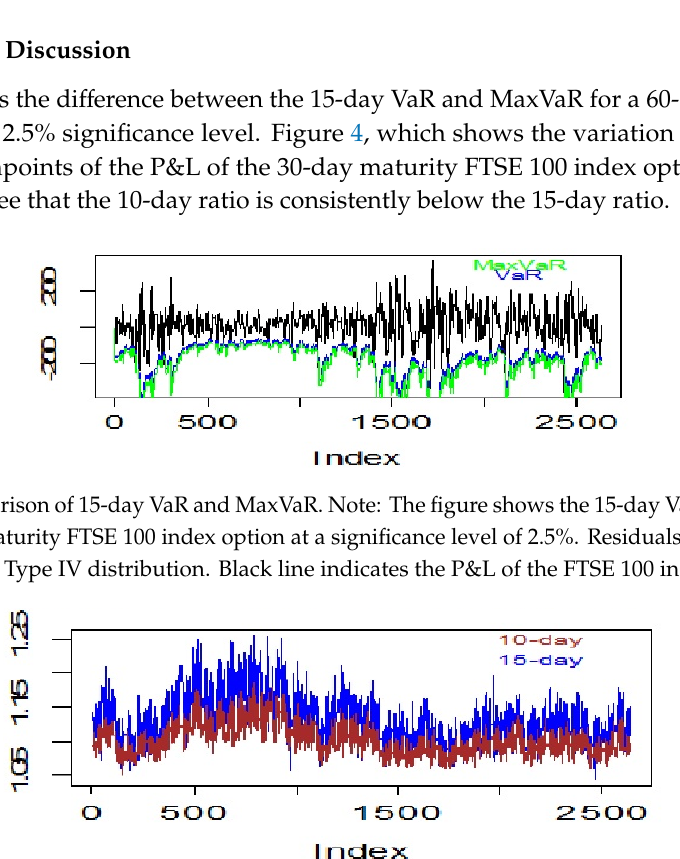
Figure 4. 10-day and 15-day inflation factor. Note: The figure shows the variation of the MaxVaR to VaR ratio for the P&L of the 30-day index option with the risk horizon (10-day and 15-day). The 15- day inflation factor is greater than the 10-day inflation factor throughout. Distribution assumed for the residuals is Pearson’s Type IV and the ratios are calculated at 1% significance level.